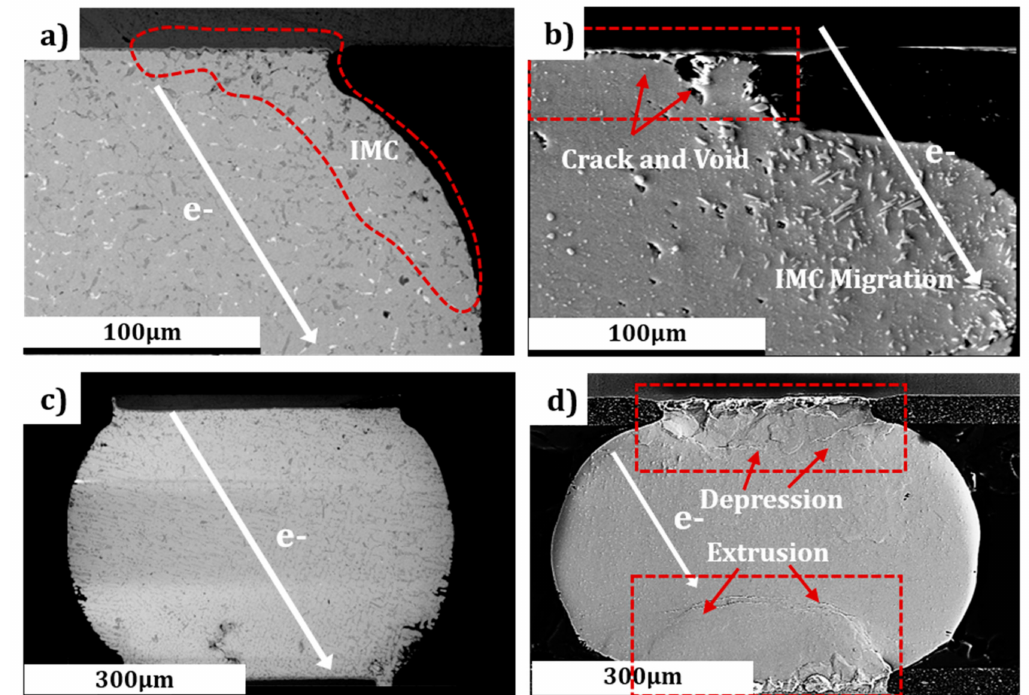
Figure 2. Scanning electron microscopy (SEM) micrographs of microstructures in electromigration (EM) failure at cryogenic temperatures (CT) and room temperature (RT). ( a ) and ( c ) are SEM images of Sn3.0Ag0.5Cu microbumps after stressing at the current density of 2.5 × 10 3 A / cm 2 for 304 h at CT ( − 196 ◦ C); while ( b ) and ( d ) are SEM images of the Sn3.0Ag0.5Cu microbumps after stressing at the current density of 2.5 × 10 3 A / cm 2 for 274 h at RT (25 ◦ C).